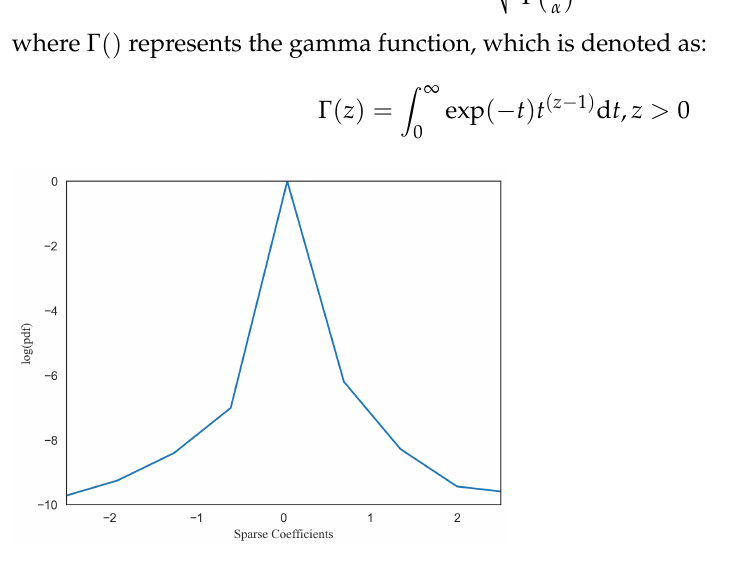
Figure 6. Histogram of all sparse coefficients for atom 1 of the learned